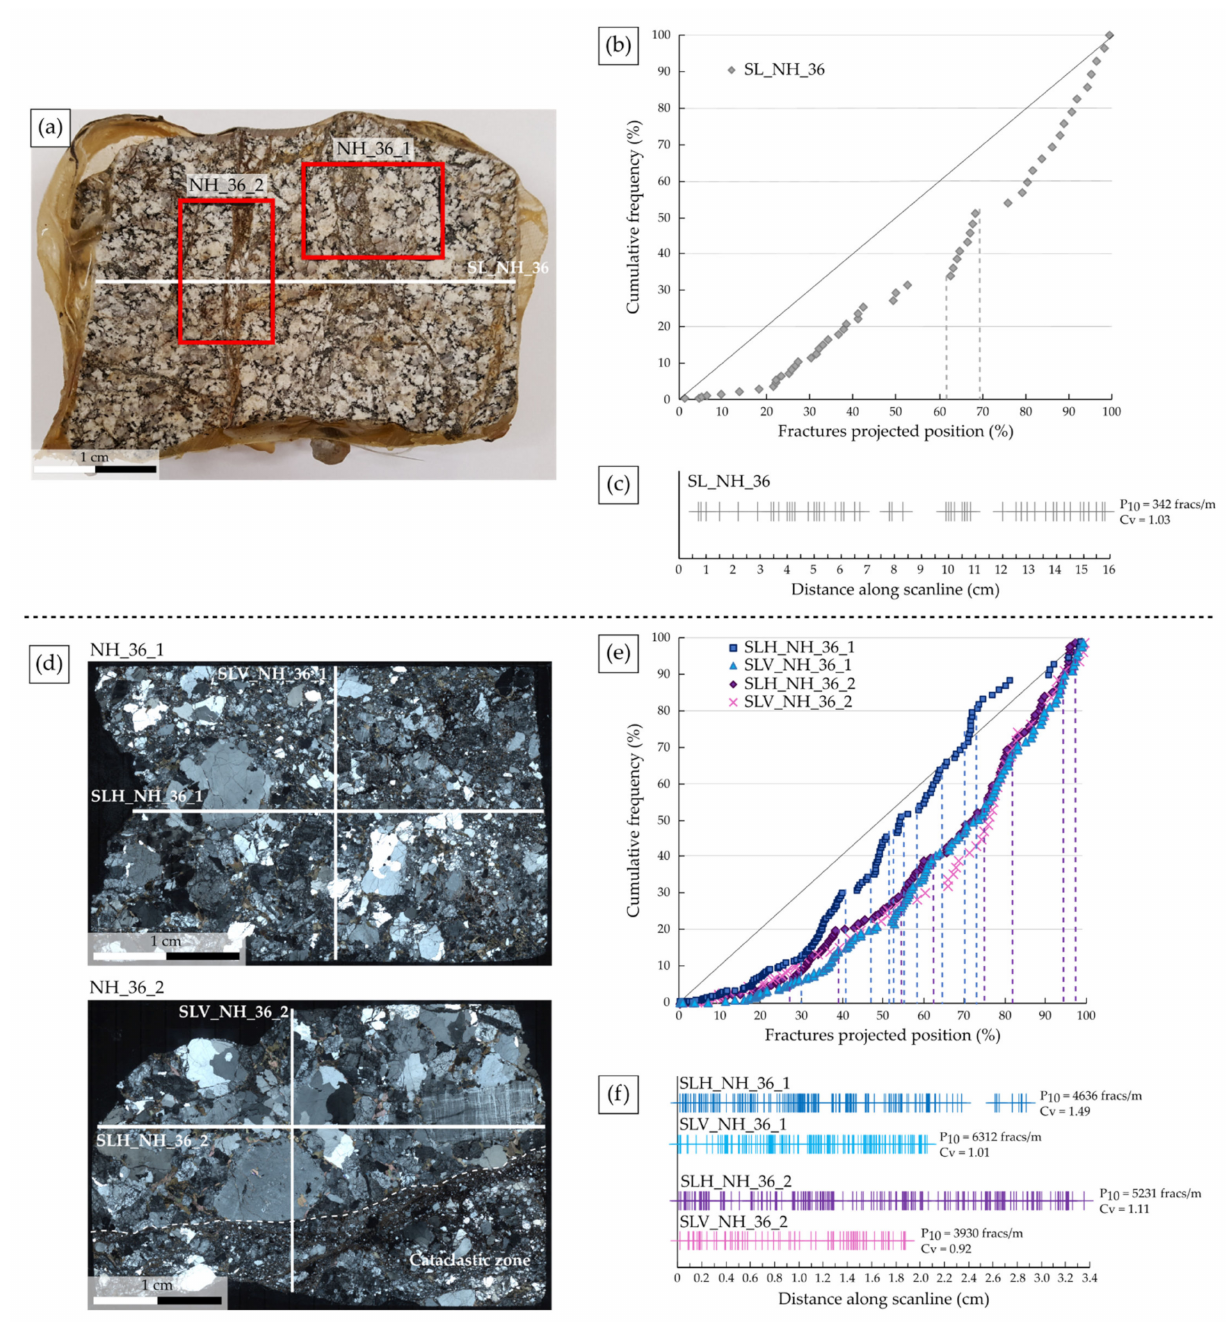
Figure 10. ( a ) Photograph of the sample NH_36 showing the scanline and the emplacement of the two thin sections made in the sample. ( b ) Plot of the cumulative frequency percentage against distance percentage for the scanline. The diagonal line represents a uniform distribution. Dashed lines indicate a cluster, meaning a zone where a rapid increase of the number of fractures is observed (slope threshold >2). ( c ) Stick plot showing the fracture position along the scanline and for which the fracture density (P 10 ) and the coefficient of variation (Cv) are given. ( d ) Thin section mosaics showing the position and the orientation of the scanlines. ( e ) Plots of the cumulative frequency percentage against distance percentage for each scanline. The diagonal line represents a uniform distribution and the dashed lines delimit a fracture cluster. ( f ) Stick plot showing the fracture position along the scanline and for which the fracture density (P 10 ) and the coefficient of variation (Cv) are given. Data were provided by